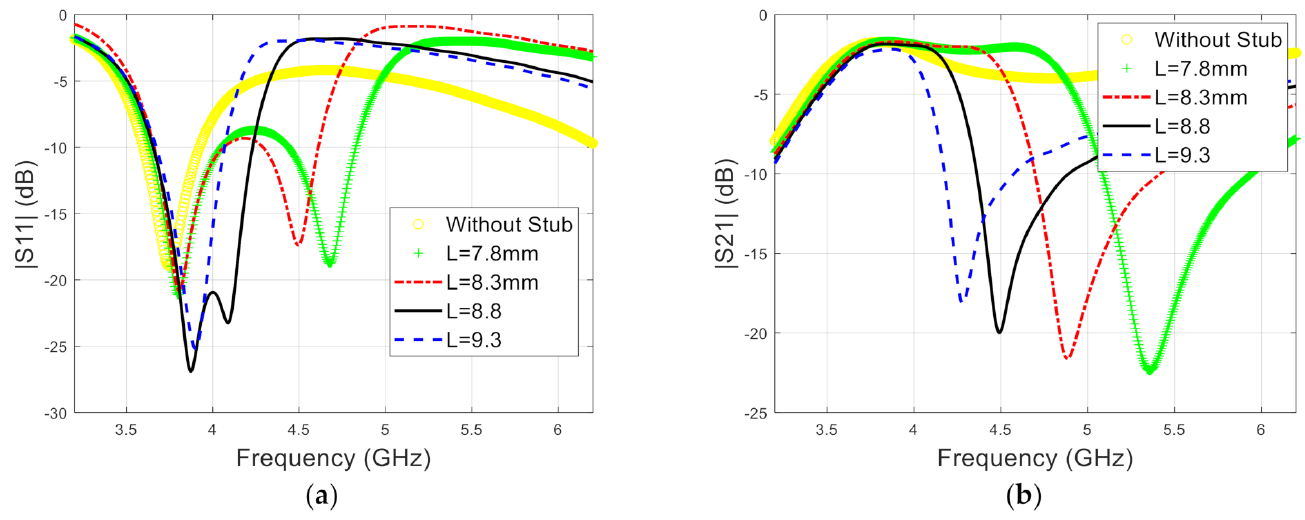
Figure 8. Simulated scattering parameters of the proposed SL-MMR based microwave filter without the parasitic elements at s = 0.2 mm and different values stub length: ( a ) reflection coefficient; and ( b ) the transmission coefficient.